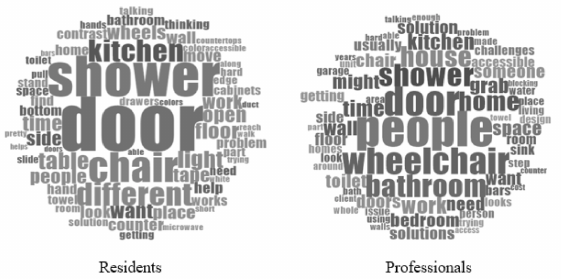
Figure 1. Word clouds of frequent words discussed by residents and